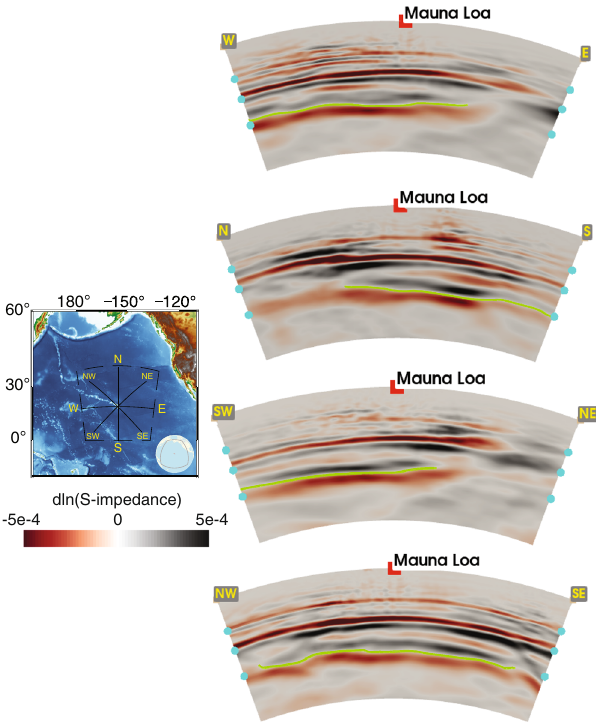
Fig. 4 | Vertical cross-sections through our impedance image centered at Mauna Loa (see map). From top to bottom: the West-East, North-South, South- west-Northeast, and Northwest-Southeast sections. The mid-mantle discontinuity inferred from this image is shown by the green lines. See Fig. 3 for the pro fi le aligned with the Hawaiian-Emperor seamount chain.